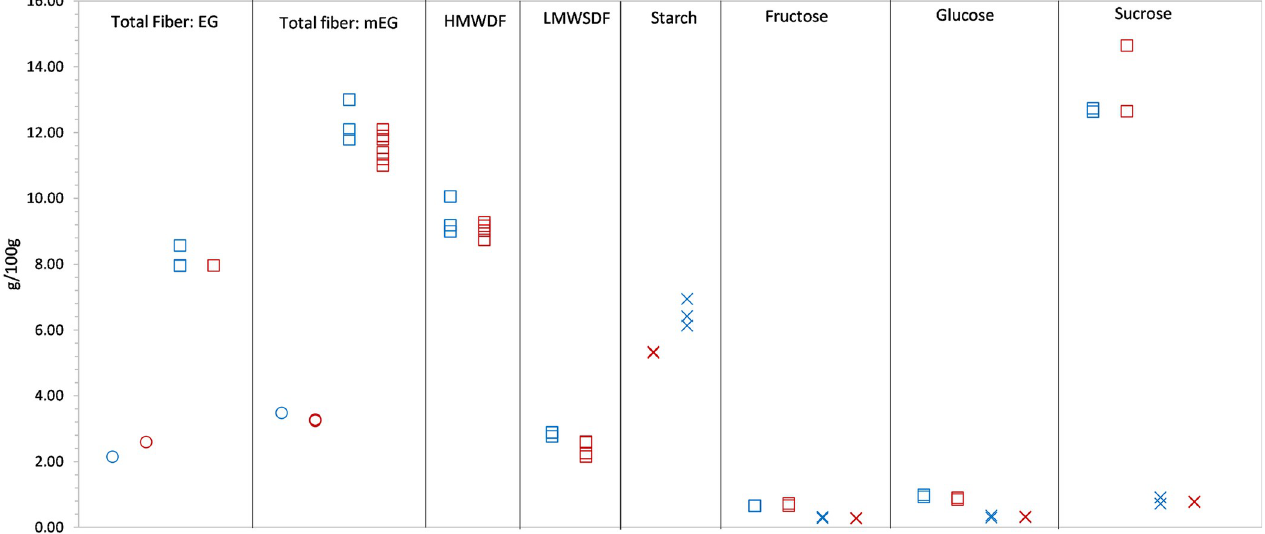
Fig 2. Results for control materials (CC) analyzed with banana samples from the ripening study (blue) and the retail study (red). EG = enzymatic- gravimetric method (AOAC 991.43) [14]; mEG = modified enzymatic-gravimetric method [16]; HMWDF = high molecular weight dietary fiber (insoluble dietary fiber and soluble dietary fiber precipitate) and LMWSDF = low molecular weight soluble dietary fiber (AOAC 2011.25) [16]. Circle ( � ) = Fiber Vegetable CC, Square ( □ ) = NIST SRM 1 3233 Breakfast Cereal, X = Starchy Vegetable II CC (see Materials and Methods); reference ranges (target ± uncertainty, g/100g) for NIST SRM 1 3233 [30]: EG total fiber, 7.8–10.2; mEG total fiber, 9.2–14.6; HMWDF, 6.4–12.0; LMWSDF, 1.8–4.2; fructose, 0.42–1.20; glucose, 0.68–1.40; sucrose, 12.67–14.17; maltose 0.37–0.55. Assayed maltose was < 0.15 g/100g in all banana samples.